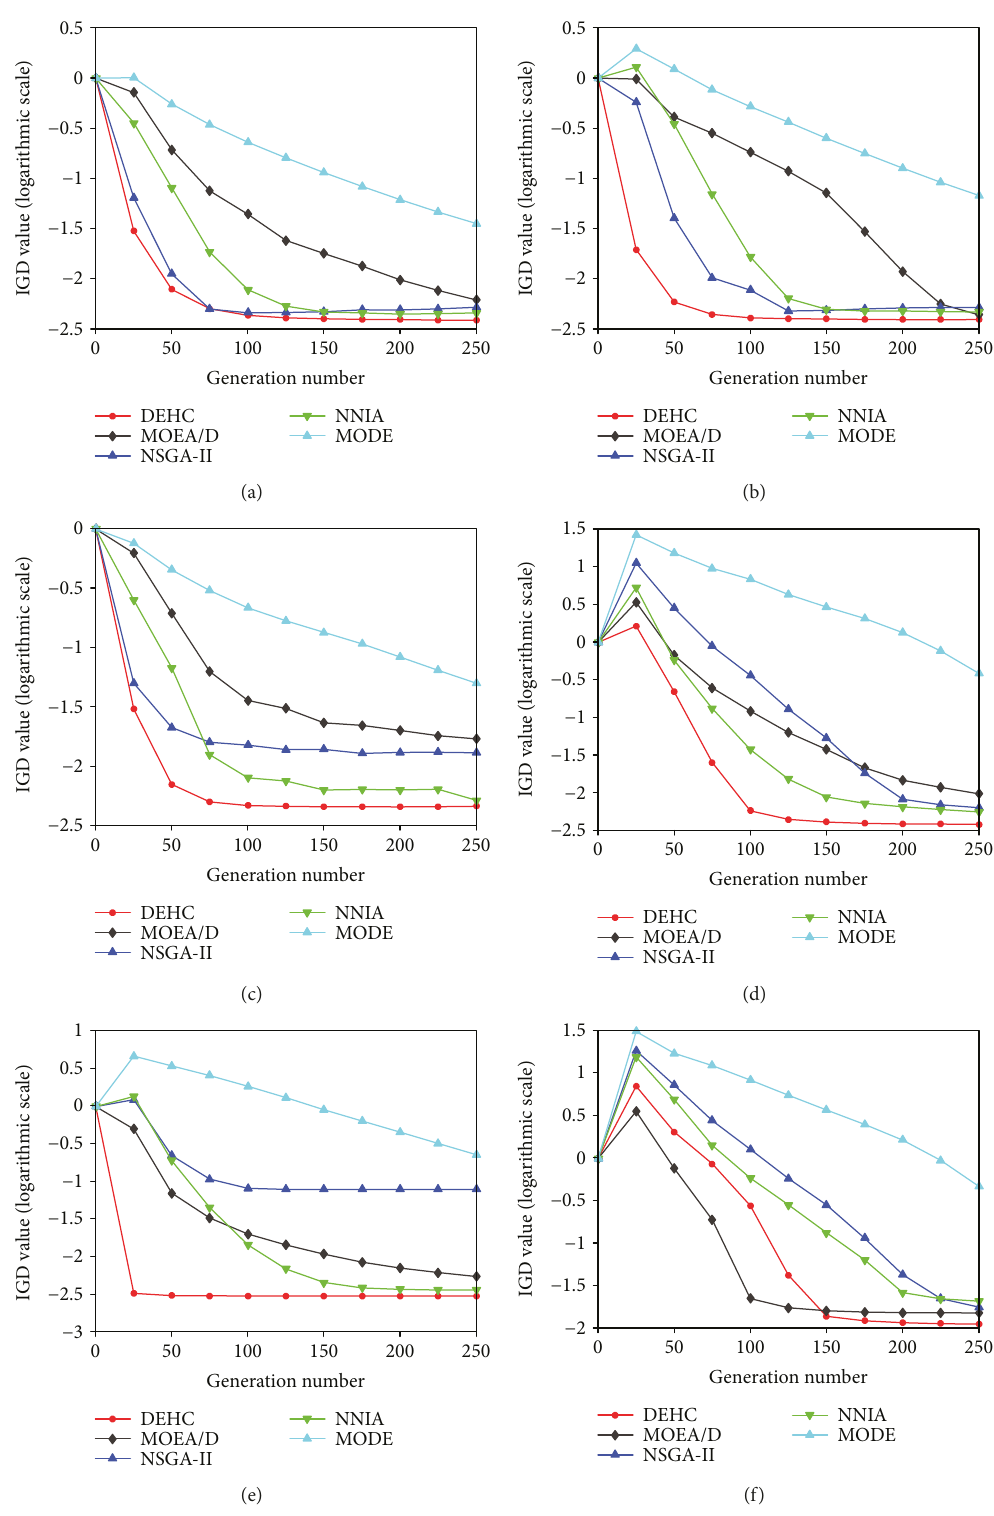
Figure 4: Median IGD values versus the evolution time. (a) ZDT1, (b) ZDT2, (c) ZDT3, (d) ZDT4, (e) ZDT6, and (f)